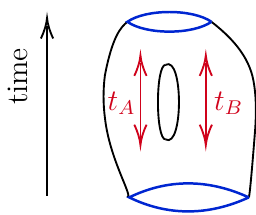
Figure 3 . The topology change of the universe. The process in which one universe splits into two and then merges into one again is